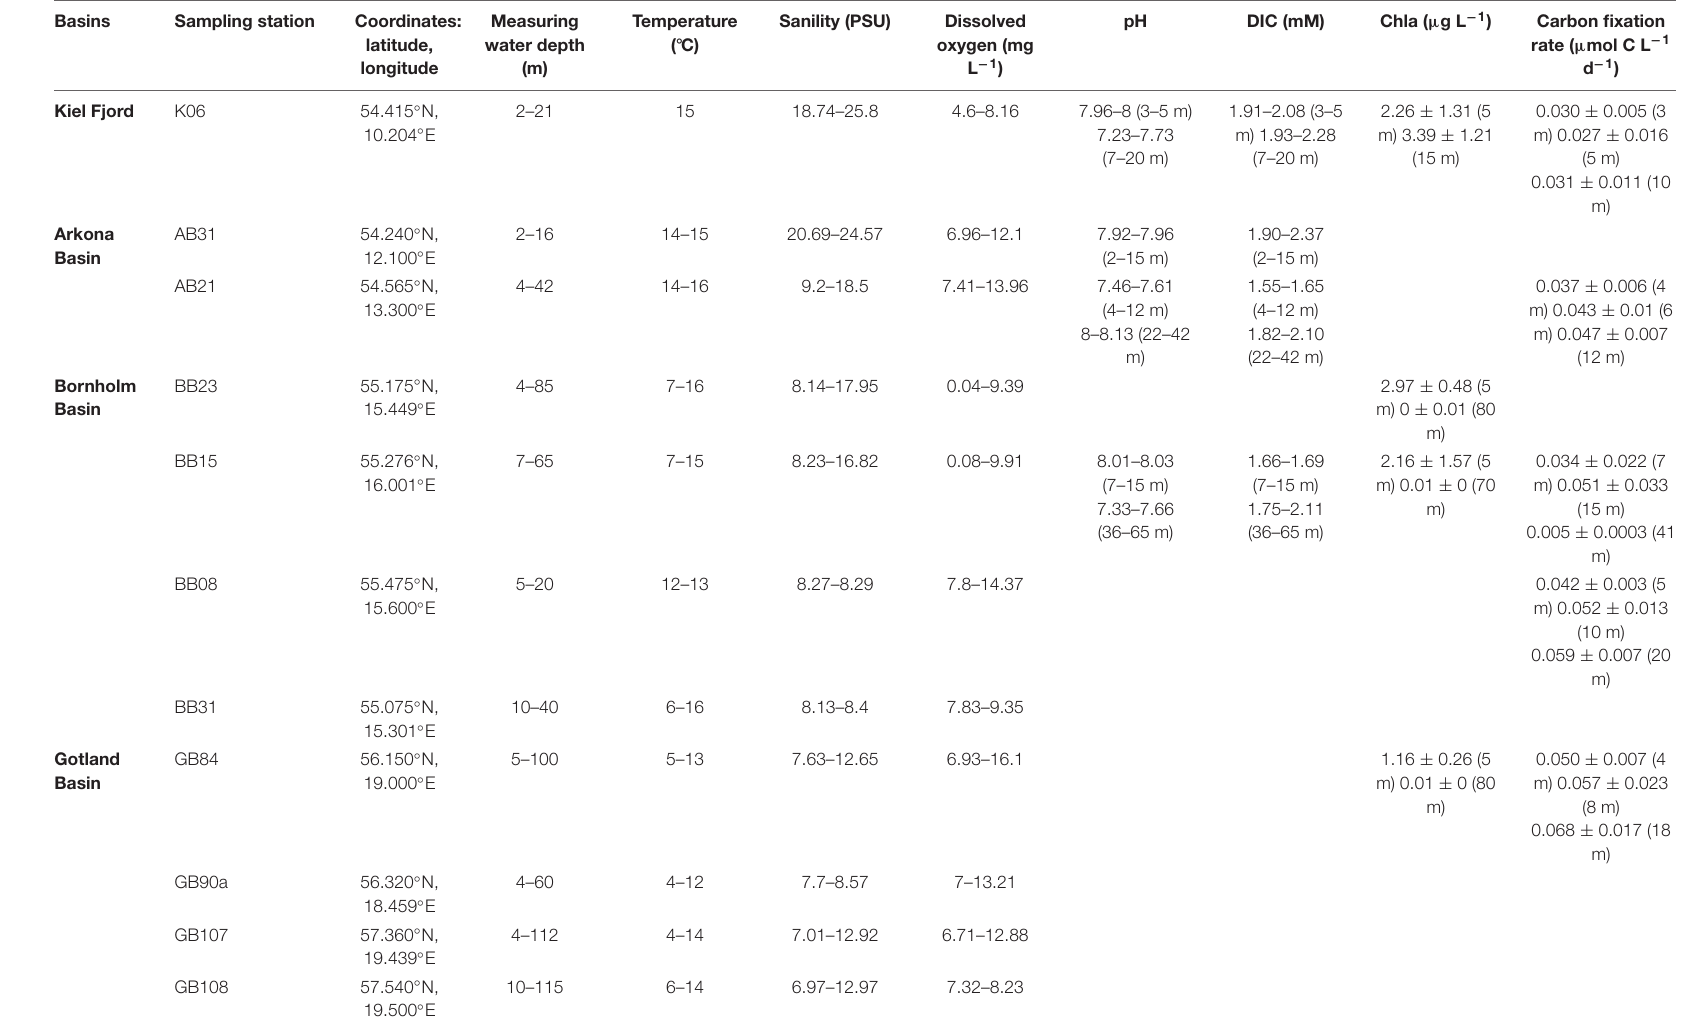
TABLE 1 | Hydrographical profile in one fjord and three different basins of the Baltic Sea.